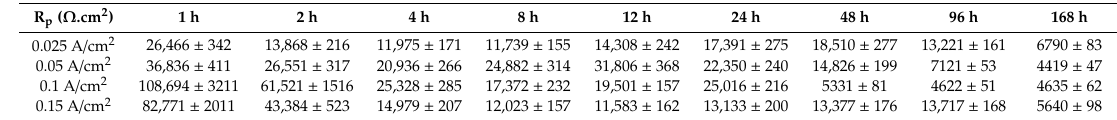
Figure 11. Nyquist diagrams of PEO coatings prepared in the electrolyte with 15 g / L Na 3 PO 4 with di ff erent applied current densities after 1 h ( a ) and 168 h ( b ). Table 11. Values of R p of PEO coatings prepared in the electrolyte with 15 g / L Na 3 PO 4 with various applied current densities measured in 0.1 M